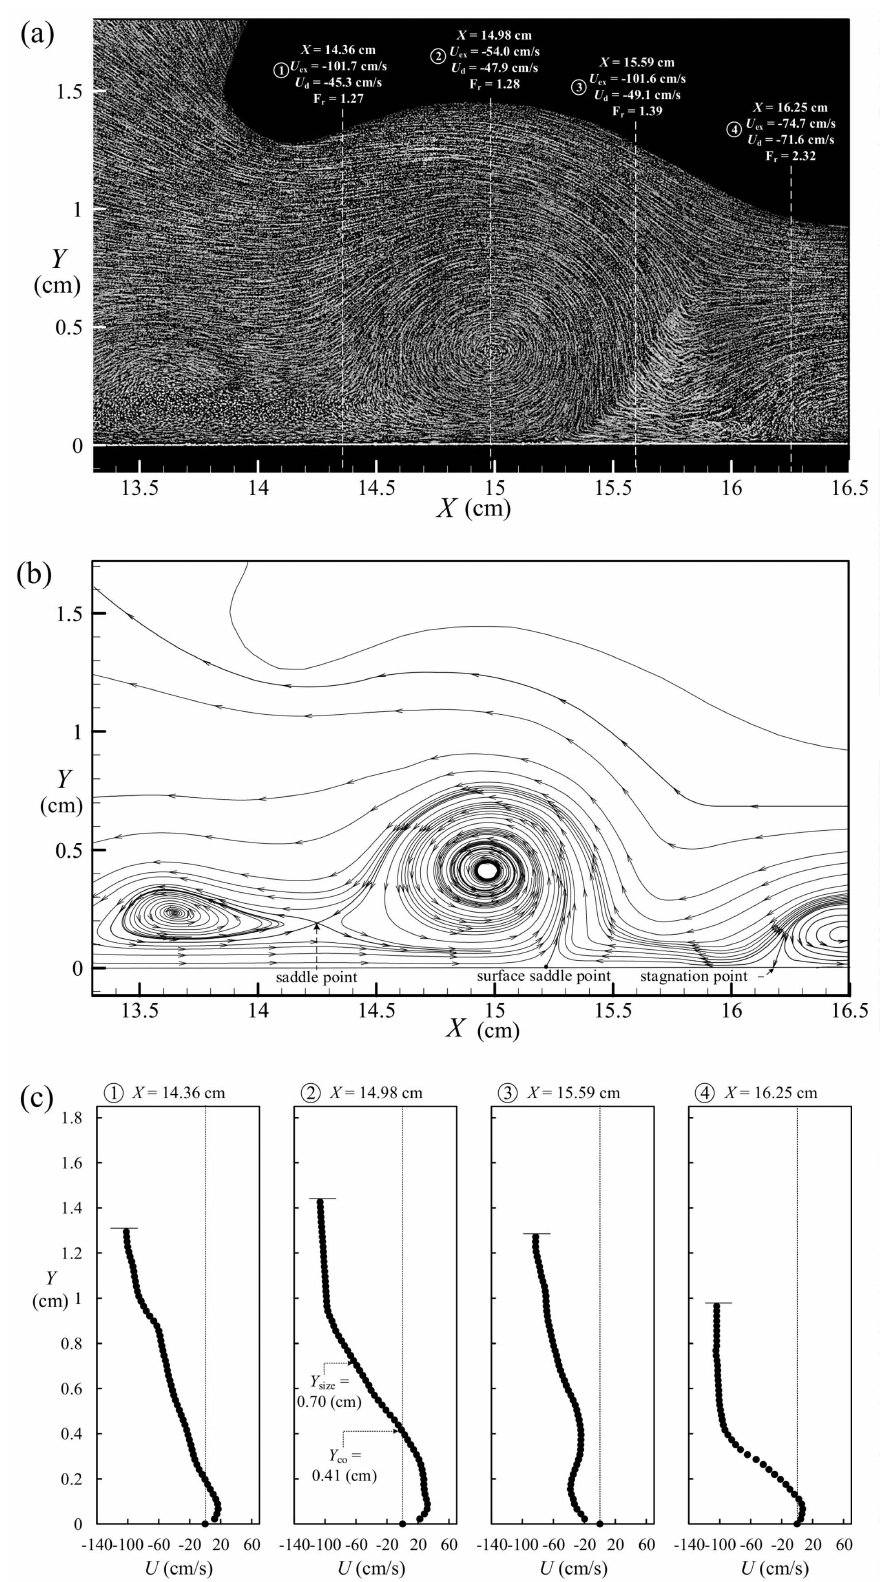
Figure 16. For t = 1.077 s, ( a ) visualized image with external stream moving offshore; ( b ) streamlined pattern; and ( c ) four velocity profiles U ( Y ) measured at four different positions, as marked by dashed lines on ( a